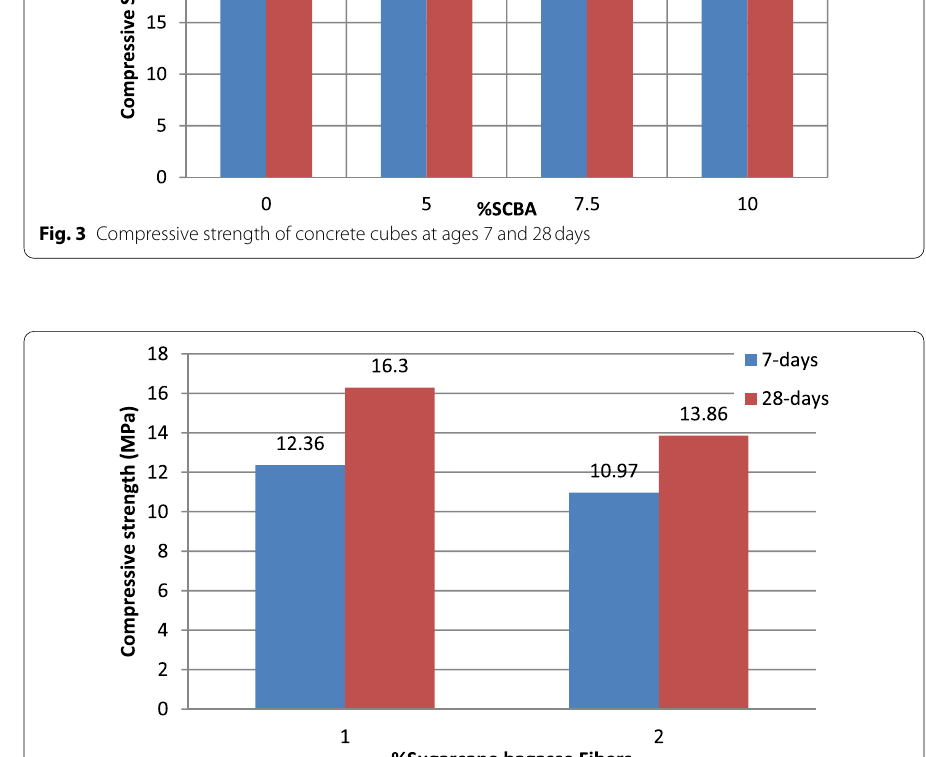
Fig. 4 Compressive strength of concrete cubes at ages 7 and 28 days made by using sugarcane